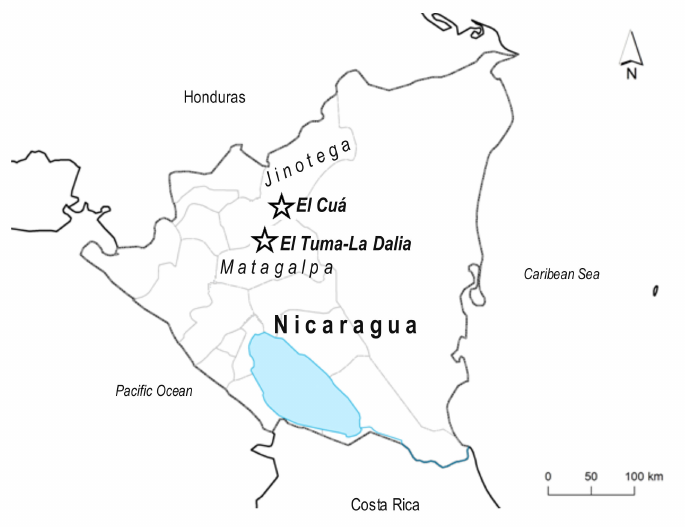
Figure 1. Location of the study area.